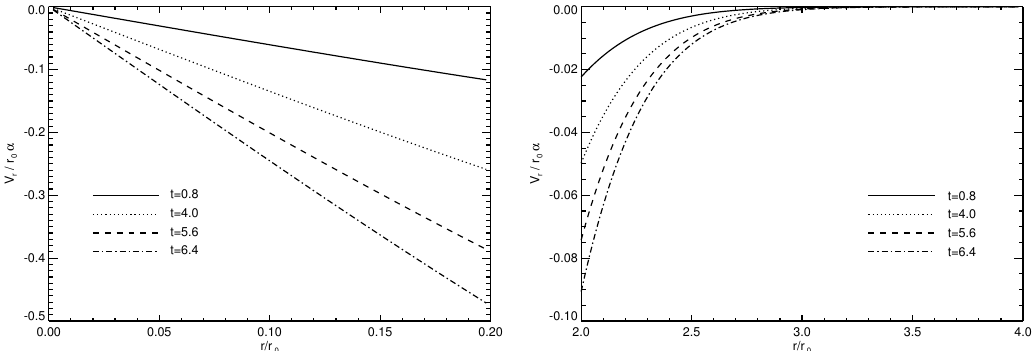
Figure 1. The normalized radial velocity (V r /r 0 α) as a function of r/r 0 and time t = 0 . 8, 4.0, 5.6, and 6.4s. The r/r 0 dependance is shown for two separate radial intervals: 0 < r/r 0 < 0 . 2 (left) and 2 < r/r 0 < 4 (right).